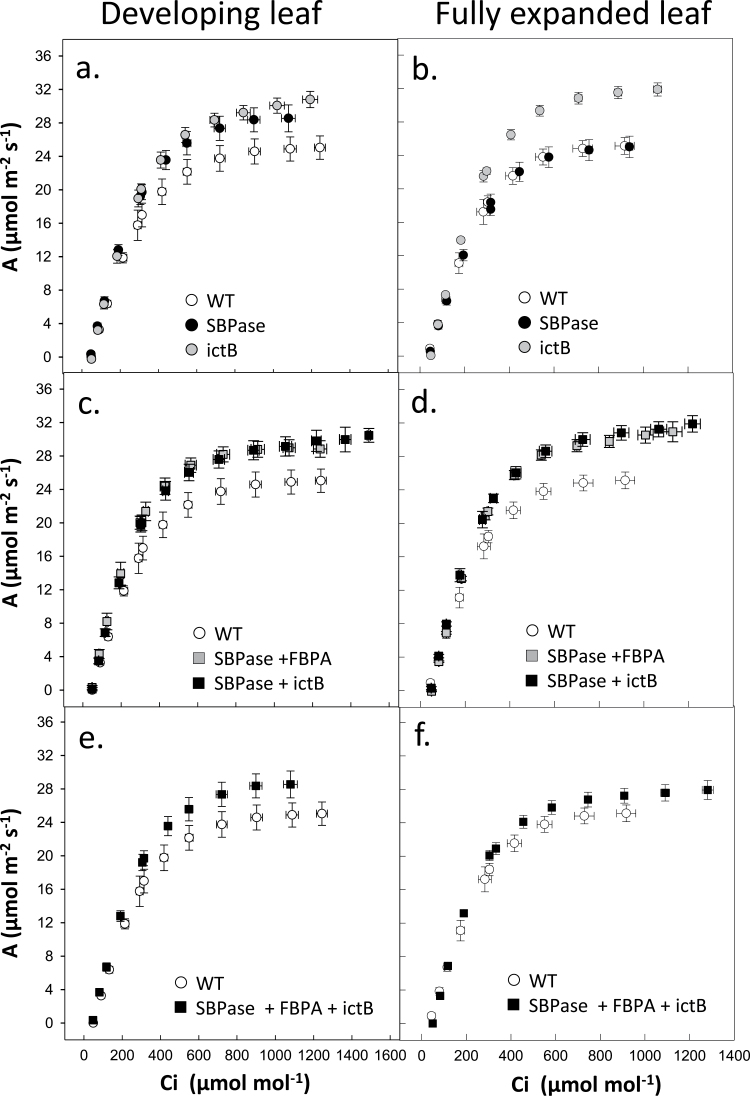
Photosynthetic responses of WT and transgenic plants grown in high light in the greenhouse. Photosynthetic carbon fixation rates were determined as a function of increasing CO2 concentrations (A/C
i) at saturating-light levels in developing leaves (11–13cm in length) and fully expanded (leaf 8) from WT and transgenic plants. (a, c, e) Developing leaves; (b, d, f) fully expanded leaves. Plants were grown in natural light conditions in the greenhouse, light levels were between 600 and 1500 μmol m–2 s–1 (supplemental light maintain a minimum of 600 μmol m–2 s–1). White circles, WT plants (n=6); black circles, SBPase over-expressing plants (n=8) (Lefebvre et al., 2005). Values are from 12–16 individual plants from 3–4 independent transgenic lines.